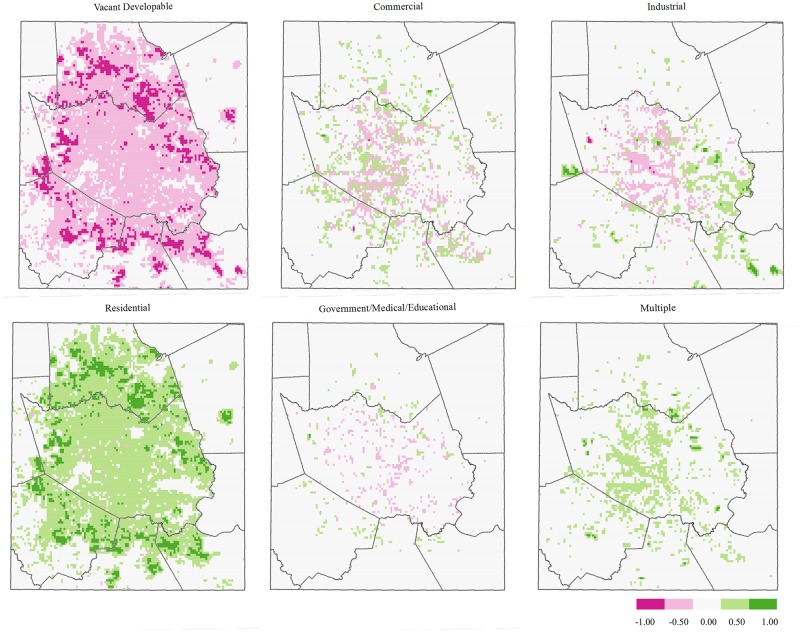
Difference maps (2040–2010), HGAC land use type.Red represents the loss of a specified land use type, whereas green represents a gain.